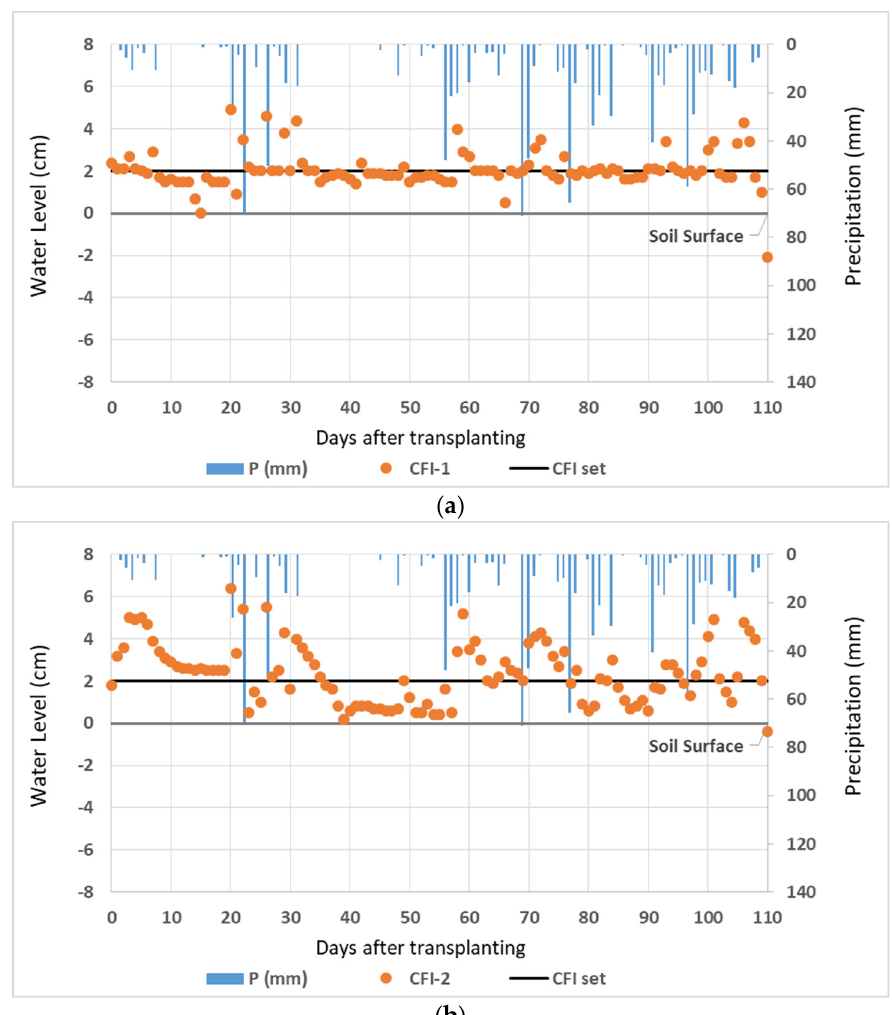
Figure 5. The actual field condition of water levels: ( a ) CFI-1; ( b ) CFI-2. On the other hand, water levels tend to be lower when no rain event occurs for several days. As at 32–42 DAT, the water level decreased from 3.6 cm to 0.8 cm. Although it was set at the same setpoint, CFI-1 showed better performance. The average water levels were 2 cm and 2.4 cm for CFI-1 and CFI-2, respectively. Even though they fluctuated, the water levels were close to the desired level, indicating that the evapotranspirative control system worked well in this regime.